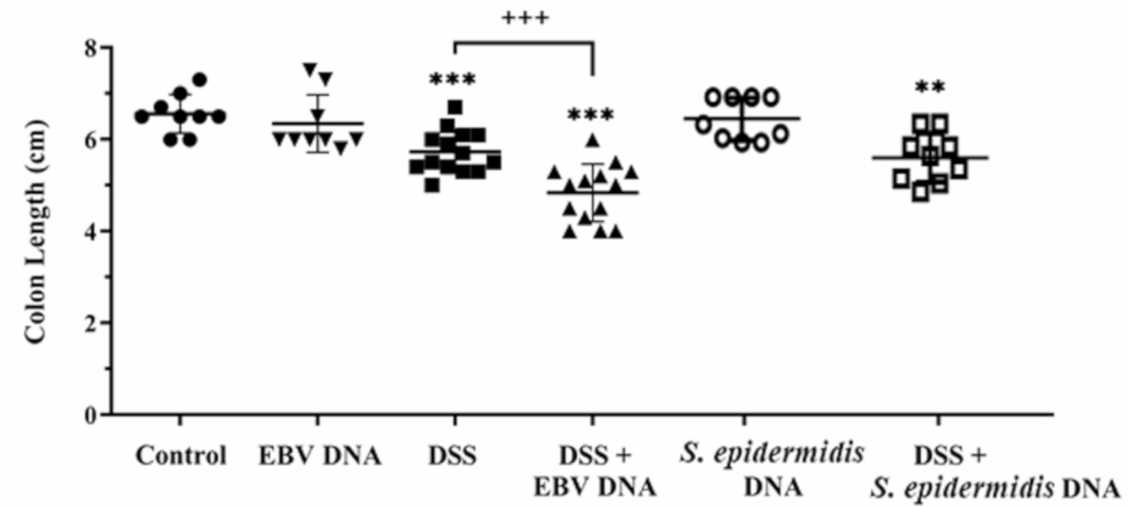
Figure 3. Average colon lengths in control and experimental mouse groups used to assess the effect of Epstein–Barr virus (EBV) DNA on colitis severity in C57BL/6J mice. C57BL/6J mice ( n = 9–14 per group) received either 1.5% dextran sodium sulfate (DSS)-containing or regular drinking water for 7 days. Three DSS-treated groups were then rectally administered sterile water, Epstein–Barr virus DNA in sterile water or S. epidermidis DNA in sterile water on day 3. The other normal drinking water-fed groups were included as controls and also received sterile water, EBV DNA or S. epidermidis DNA by rectal gavage on day 3. On day 7 of the experimental protocol, mice were sacrificed and their colon lengths were measured. Average colon lengths per group and standard deviations are indicated. *** p < 0.001, compared to the control group; ** p < 0.01 compared to the control group; +++ p < 0.001, compared to the DSS